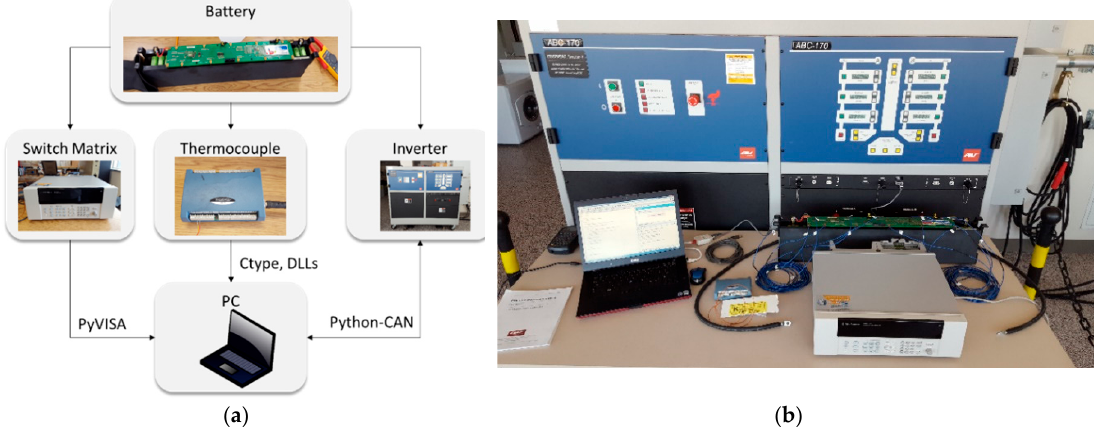
Figure 14. The system view ( a ) simplified block diagram ( b ) photograph of the system.